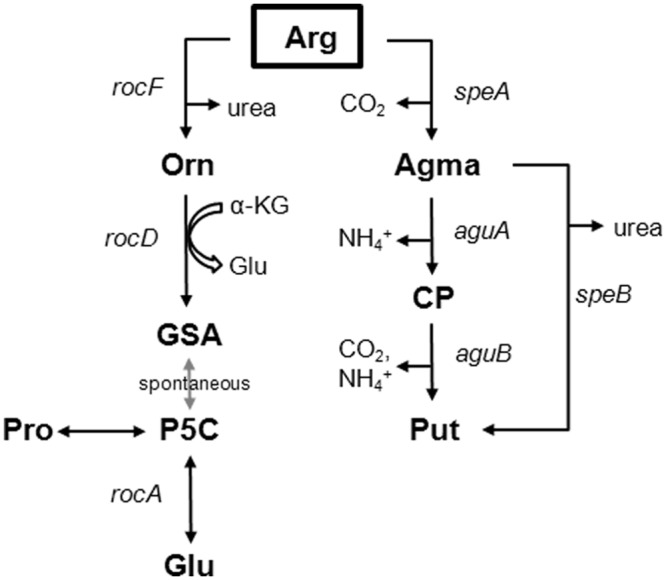
Scheme of the arginase pathway and the arginine decarboxylase pathway.In Bacillus subtilis, the first reaction of the arginase pathway, the formation of ornithine (Orn), is catalyzed by arginase (rocF). RocD, an ornithine aminotransferase, utilizes ornithine to form glutamate semialdehyde (GSA) or pyrroline-5-carboxylate (P5C). P5C is the substrate of RocA, a pyrroline-5-carboxylate dehydrogenase, which produces glutamate (Glu). In Yersinia pestis, an arginine decarboxylase (speA) forms agmatine (Agma). Agma is further degraded to N-carbamoylputrescine (CP) and putrescine (Put) by aguA, aguB, and speB. The genome of Mtb includes homologues for the arginase pathway (rocD, rocA) and the arginine decarboxylase pathway (speA / adi).